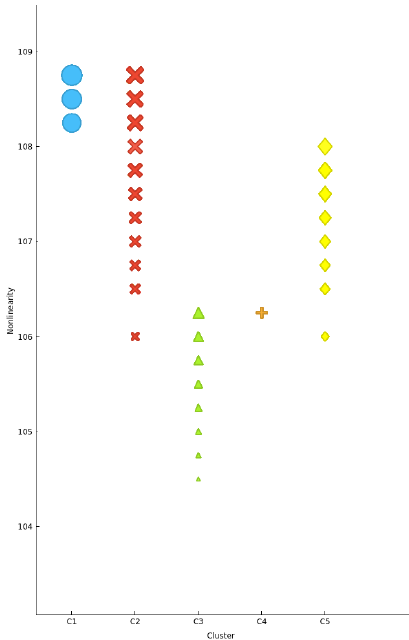
Figure 7. SFS OBL clusters of solutions.